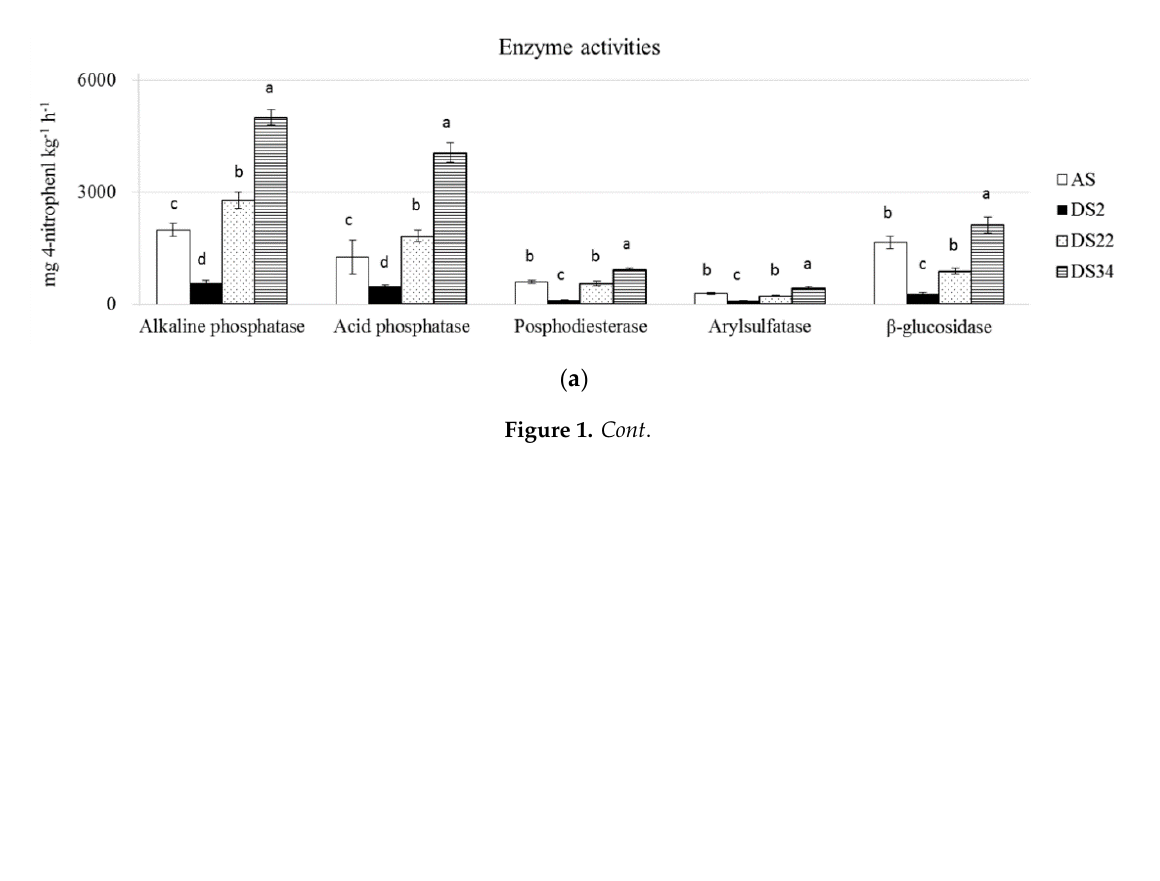
Table 2. Basal respiration of the arable soil and de-sealed